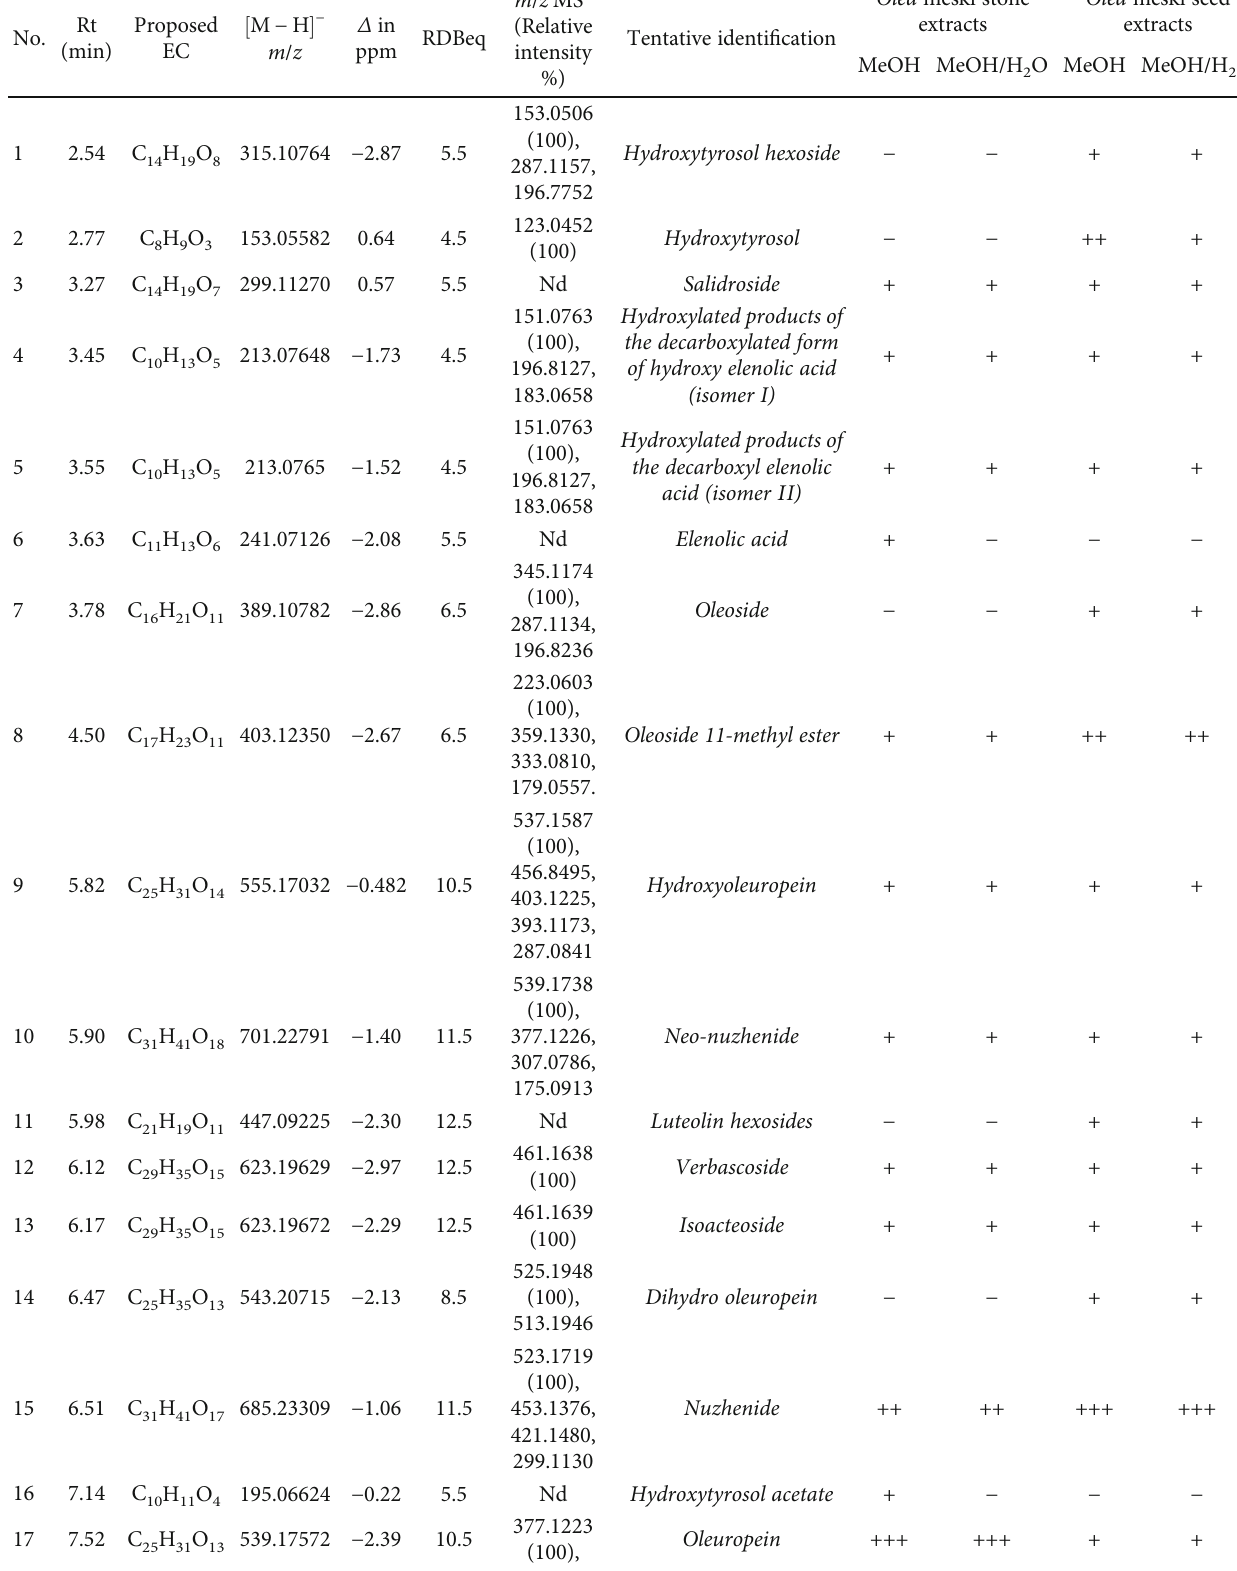
Table 1: Secondary metabolites detected in the di ff erent Olea europaea meski stone and seed extracts.